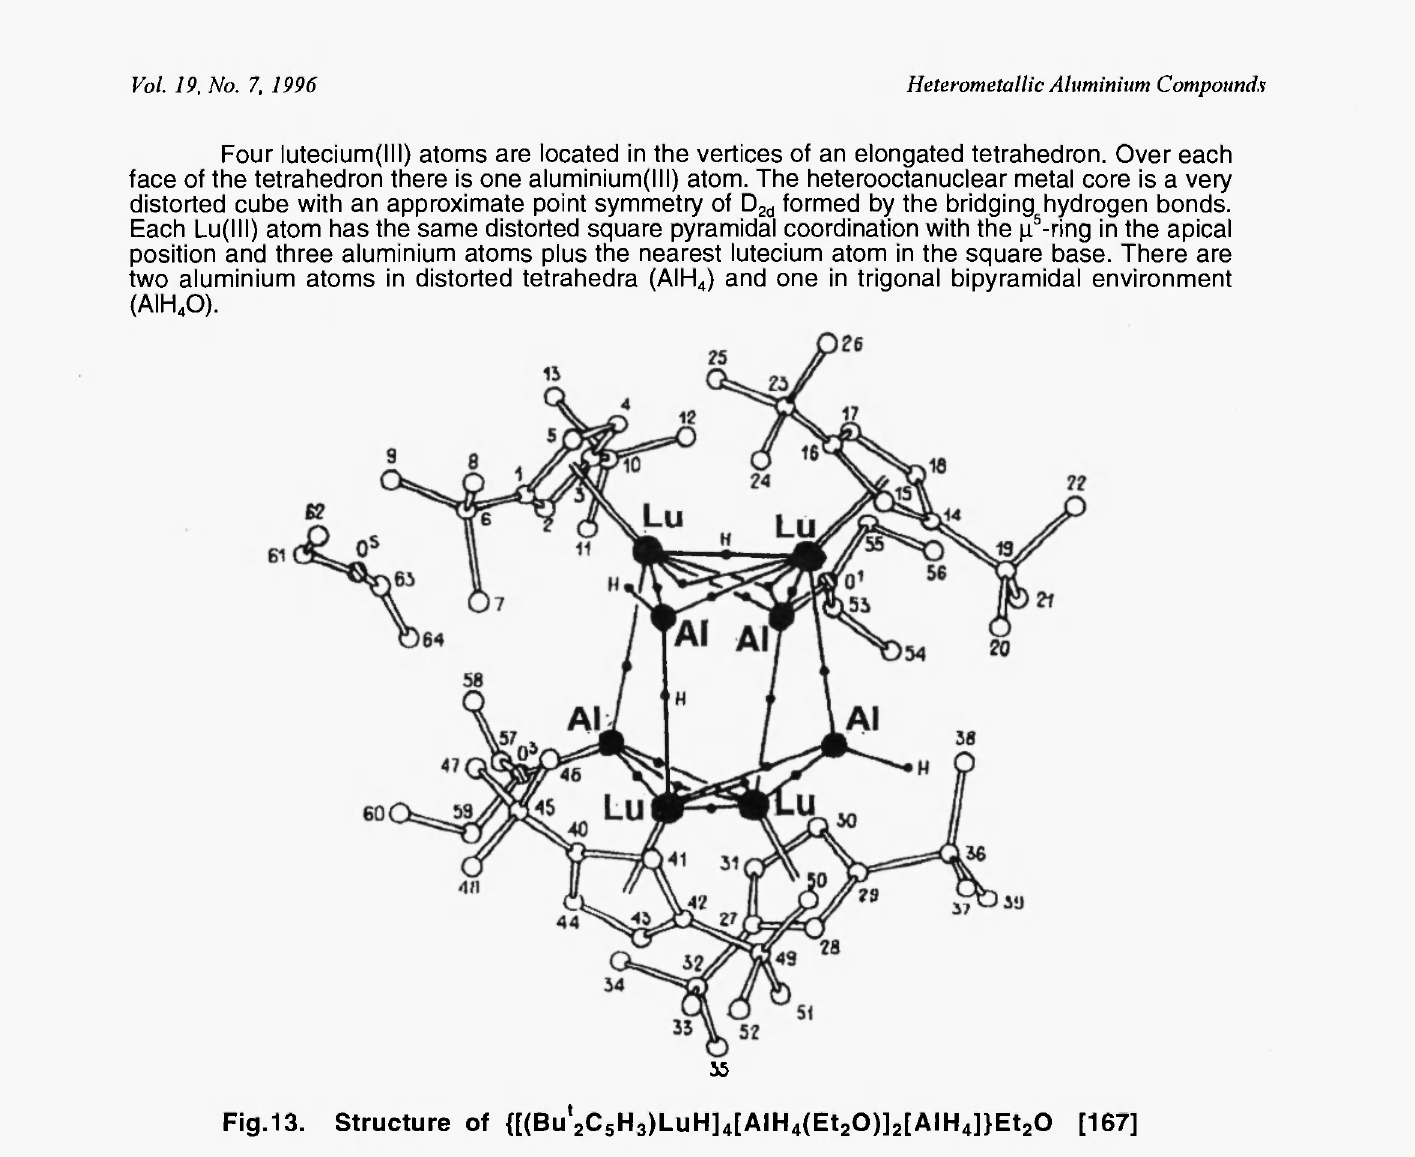
Fig.13. Structure of {[(Bu , 2 C 5 H3)LuH]4[AIH4(Et 2 0)] 2 [AIH4]}Et 2 0